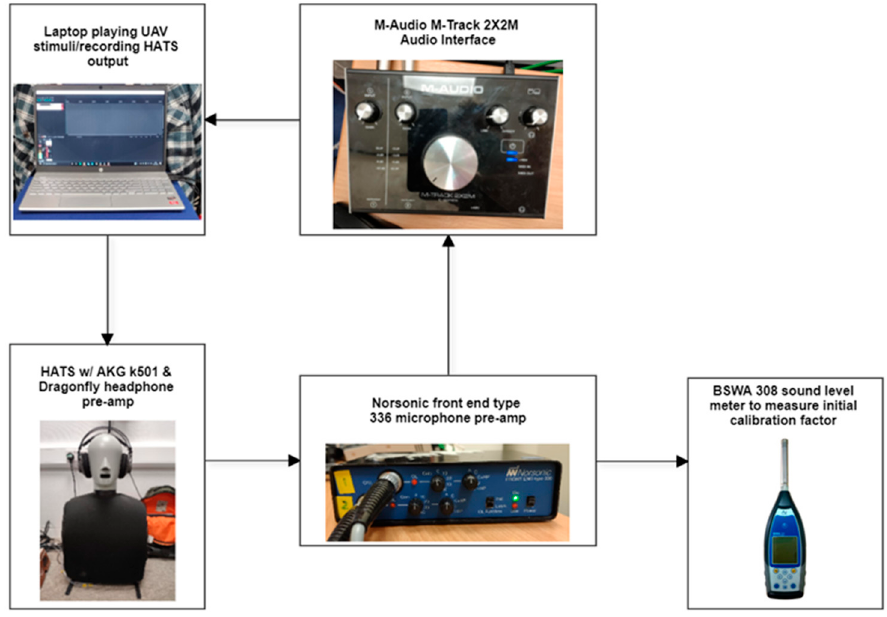
Figure 1 . Calibration setup used for subjective test drone stimuli. Figure 1. Calibration setup used for subjective test drone